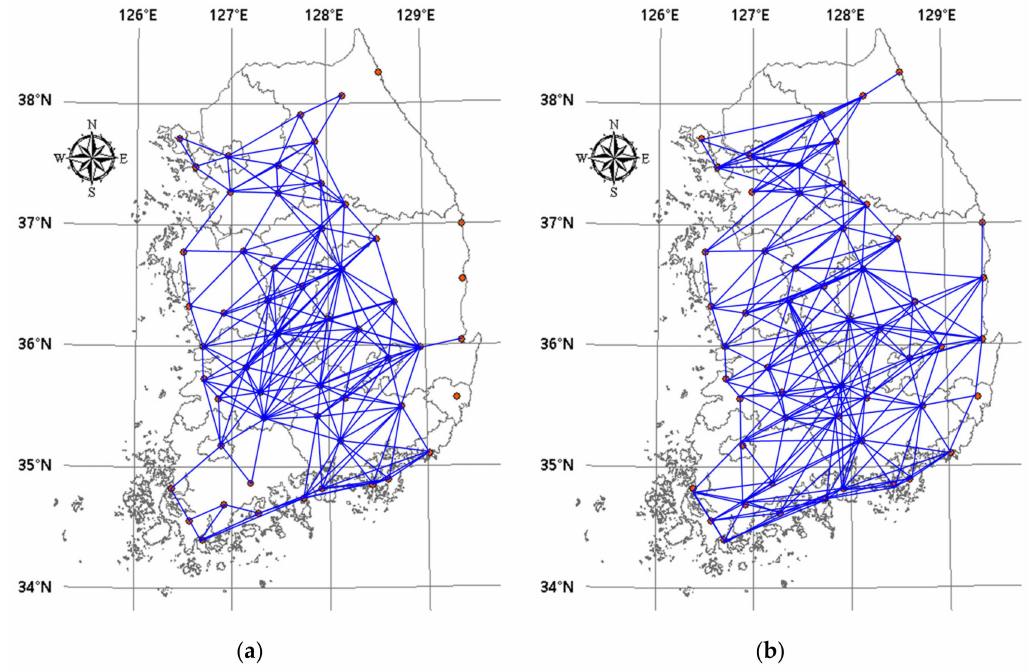
Figure 6. Complex network connected by threshold 0.7: ( a ) mutual information; ( b ) Pearson correlation. The centrality values were computed for these two networks. Based on these computed values, each station was ranked according to its importance (Figures 7 and 8). If we examine the ranks of stations according to threshold values, the rank by mutual information is less sensitive to threshold than that by Pearson correlation. Especially, Pearson correlation shows large variability in the ranks of stations according to threshold values rather than data characteristics. Therefore, there is the problem of using Pearson correlation for analyzing the importance of stations. However, mutual information that is not sensitive to threshold values can be used for the evaluation of rain gauge